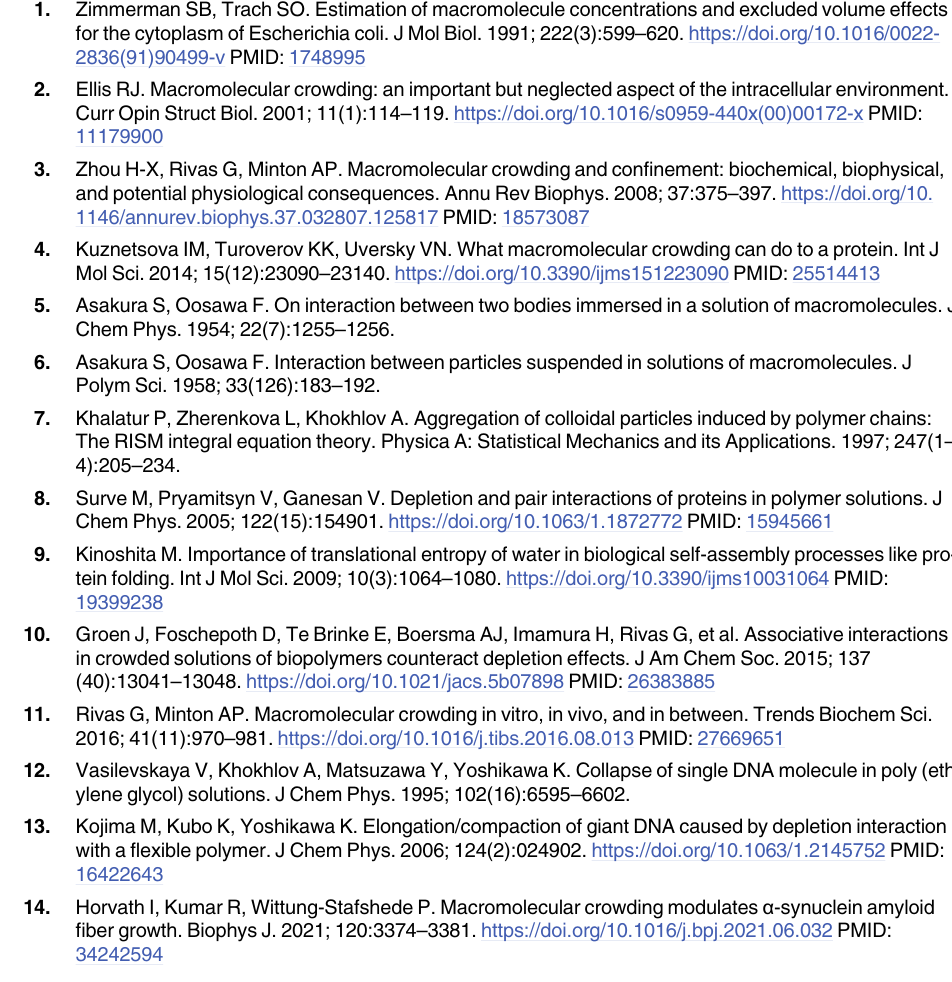
S1 Fig. Evaluation of the hydrodynamic radius R analysis of Brownian